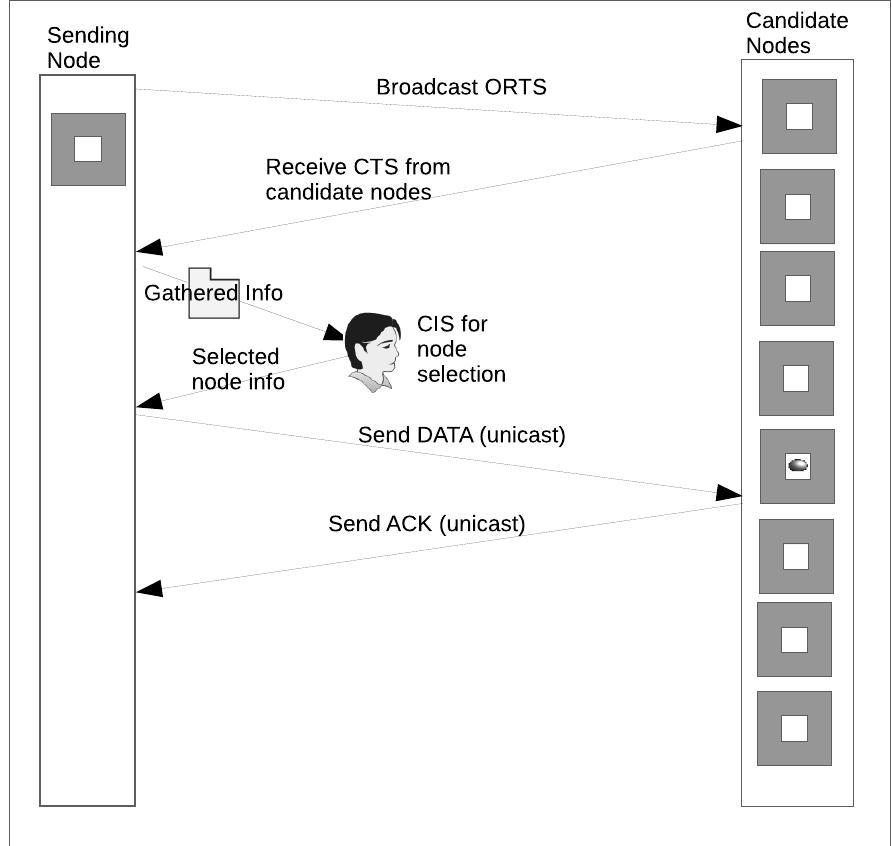
Figure 2. Forwarding